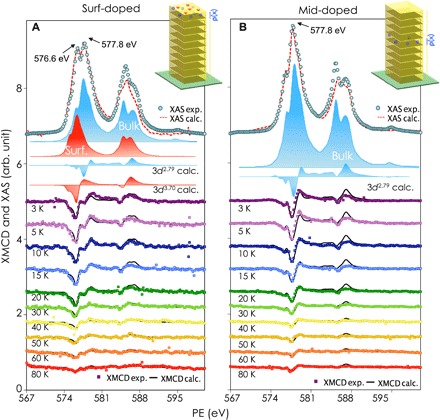
The modulation-doped Bi2Se3.Typical total XAS and XMCD and their deconvoluted spectra of the (A) surf-doped and (B) mid-doped Bi2Se3 at 3 to 80 K, respectively. For the surf-doped Bi2Se3, the best fitting was obtained by a linear superposition of dsurf3.70 and dbulk2.79, with ~4:5 for the total XAS and ~2:1 for the XMCD. No appreciable Cr dsurf3.70 but only Cr dbulk2.79 was obtained from the mid-doped Bi2Se3.